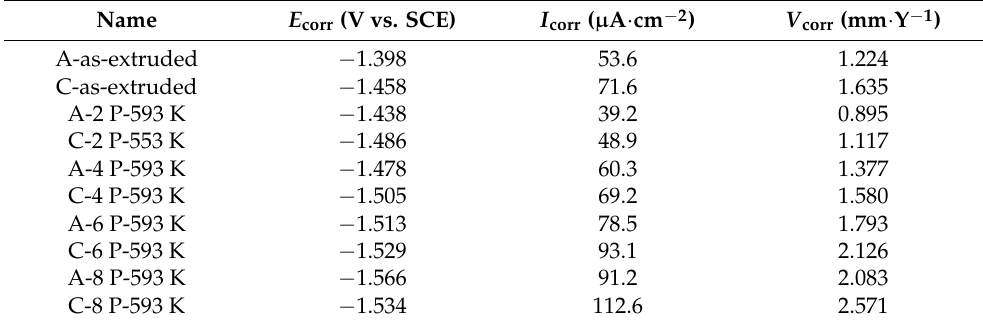
Figure 9. Potentiodynamic polarization curves of samples with different ECAP processing parameters in SBF. Table 3. Corrosion parameters of the experimental specimens obtained from polarization curves.